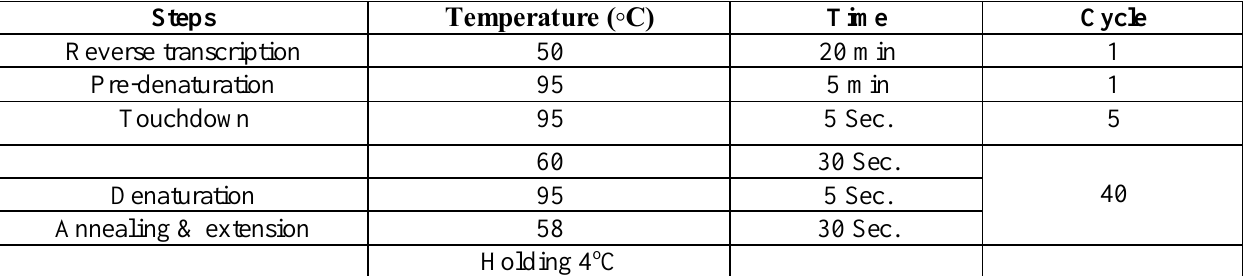
Table 1 : The PCR Run program